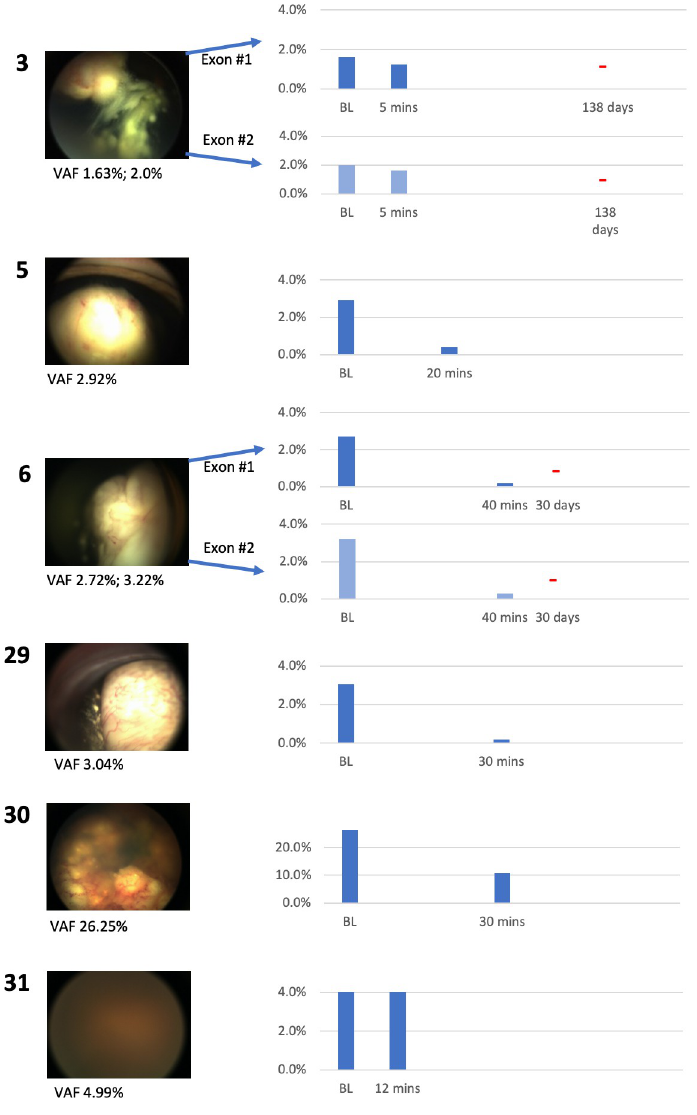
Fig 1. Fundus photographs and clustered bar graphs for four